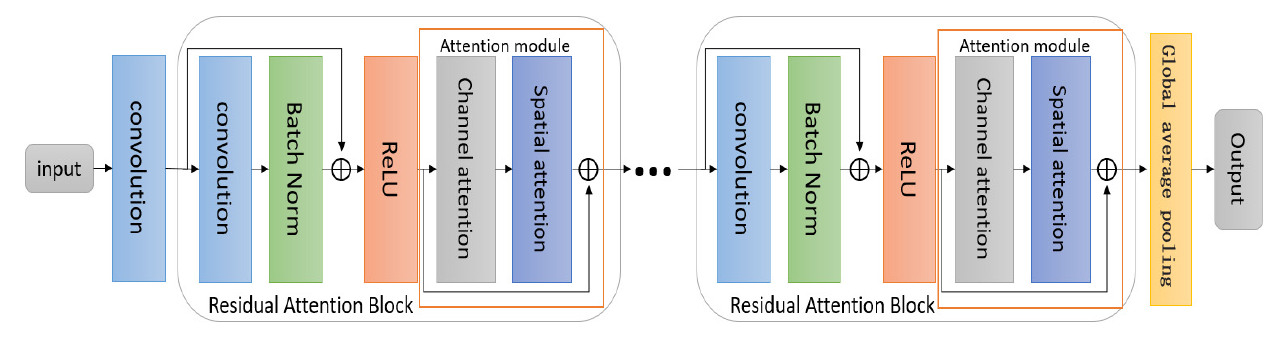
Figure 3. RCSAN: Residual Channel Spatial Attention network.